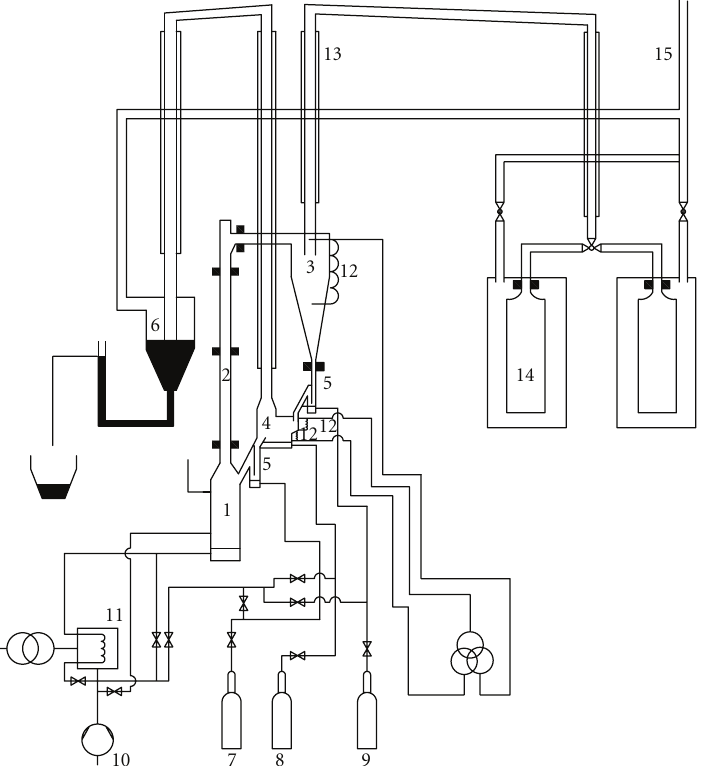
Figure 4: Schematic diagram of the prototype reactor system. (1) air ractor, (2) riser, (3) cyclone, (4) fuel reactor, (5) upper and lower particle locks, (6) water trap, (7) nitrogen (8) natural gas, (9) argon, (10) air, (11) preheater, (12) heating coils (not available for test with nickel-based particles), (13) finned tubes for cooling of gas streams, (14) filters, and (15) connection to